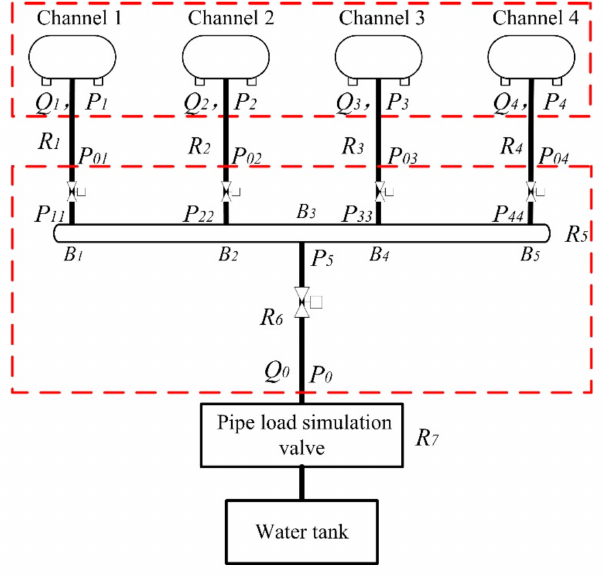
Figure 4. Schematic diagram of the dynamic characteristics of the multi-channel clustering